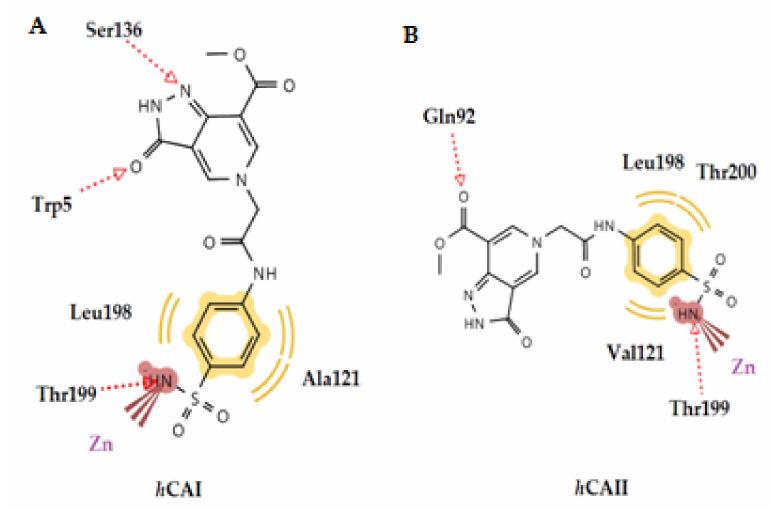
Figure 6. 2D interaction diagram of compound 1f docking pose interactions with the key amino acids in ( A ) hCA I and ( B ) hCA II.